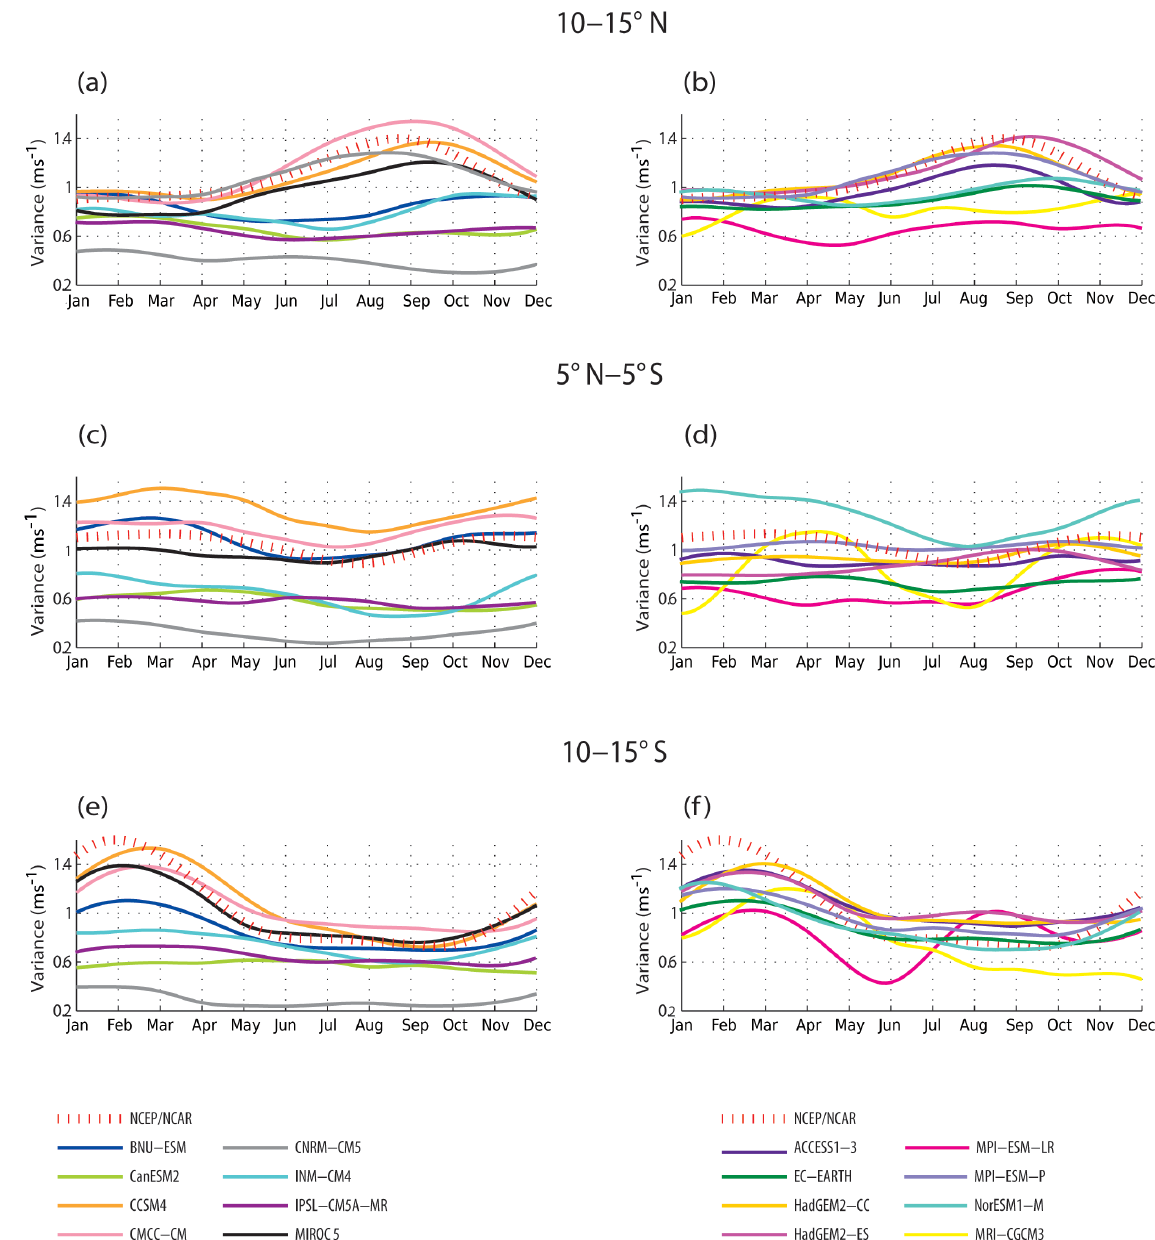
Figure 4. Seasonal variances (rms) of MJO averaged zonally over the tropical Pacific (120 ◦ E–90 ◦ W) and meridionally over (a, b) 10–15 ◦ N, (c, d) 5 ◦ N–5 ◦ S and (e, f) 10–15 ◦ S for the NCEP/NCAR Reanalysis and the